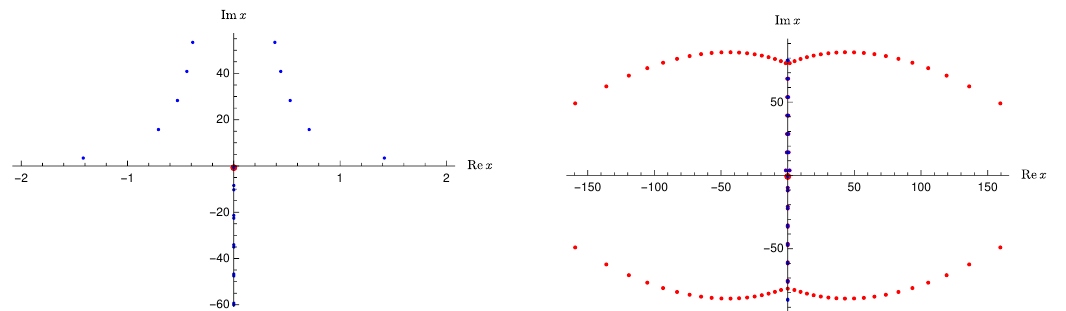
Figure 17 . The roots of eq. (5.10) (at (cid:15) = 0 . 5 ) closest to the origin in the complex x -plane (left panel). The large red dot corresponds to the perturbative root at x ≈ − 0 . 735544 i . (Note that the perturbative series (5.11) fails to converge for this value of (cid:15) .) The other roots on the imaginary axis are at x ≈ − 8 . 4414 i , x ≈ − 10 . 3128 i , x ≈ − 21 . 3770 i , x ≈ − 22 . 5885 i , x ≈ − 34 . 0718 i , x ≈ − 35 . 0365 i , x ≈ − 46 . 7093 i , x ≈ − 47 . 5349 i . In the right panel, the same set of roots as in the left panel is approximated by the first 100 roots of the polynomial (5.14). The blue dots accurately reproduce the actual values from the left panel. The purpose of the zoomed-out plot is to show the spurious, unphysical red dots which move to infinity as the order of approximation is